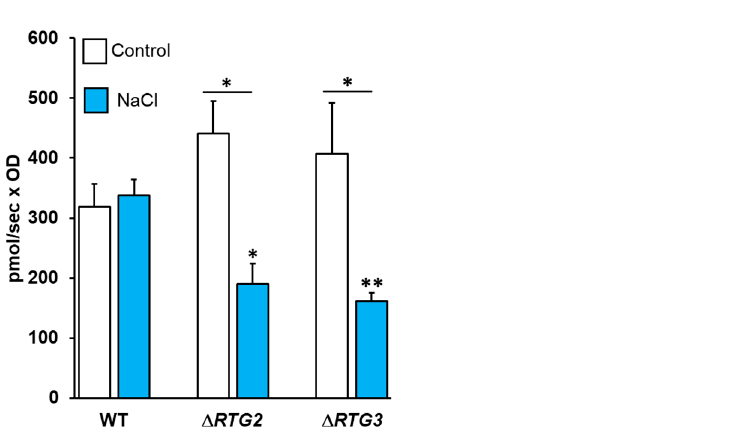
Figure 6. Mitochondrial basal respiration of wild-type and RTG mutants. Wild-type (WT), ∆ RTG2 and ∆ RTG3 cells, grown overnight in YPD medium, were diluted to 0.1 OD 600 in fresh liquid YPD with or without 0.8 M sodium chloride (NaCl). After 24 h, cells were collected and resuspended in the same medium to a final optical density of 5 OD 600 units/mL. Oxygen consumption was measured with an Oxygraph-2 k system, and experimental data were analyzed using DatLab software. Unpaired Student’s t -test: a statistically significantly difference with * p < 0.05 when comparing ∆ RTG2 and ∆ RTG3 control versus NaCl, respectively, or wild-type NaCl versus ∆ RTG2 NaCl, and ** p < 0.01 when comparing wild-type NaCl versus ∆ RTG3 NaCl from three independent experiments.